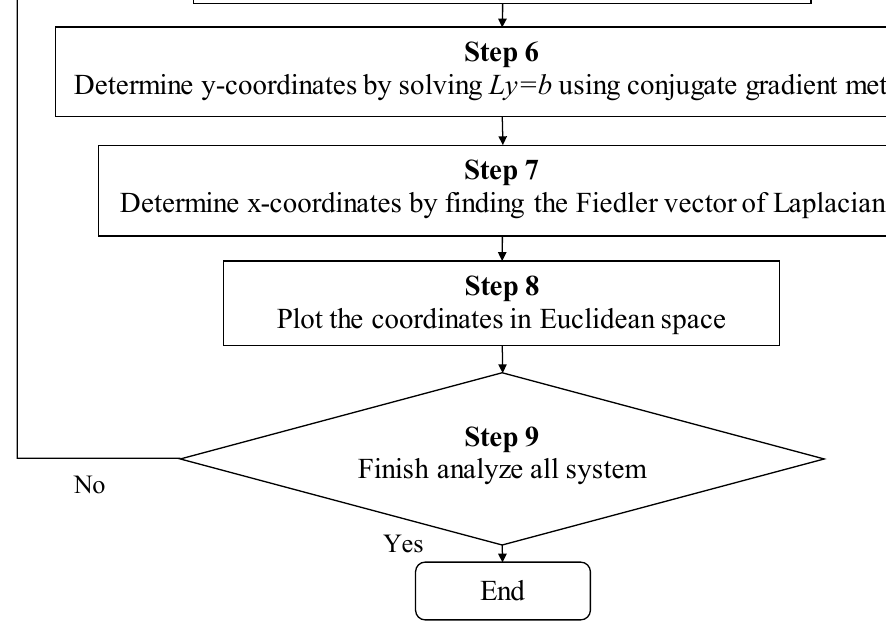
Figure 2. The flow chart of the c-FACS algorithm.